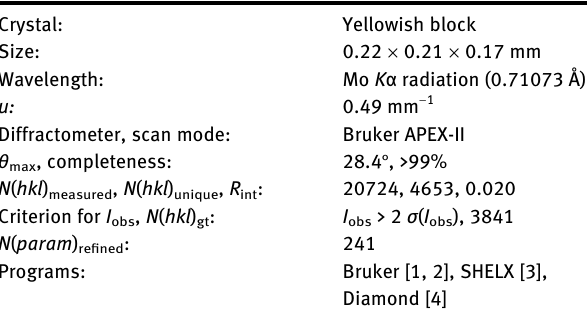
Table  : Data collection and handling. Table  : Fractional atomic coordinates and isotropic or equivalent isotropic displacement parameters (Å 